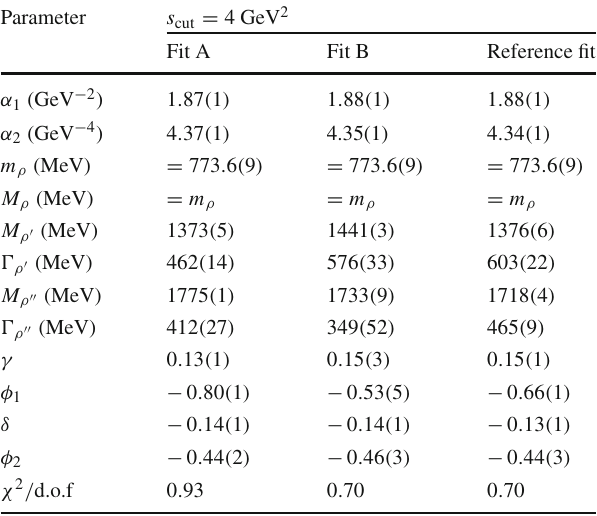
Table 3 Results for the fits obtained with a three-times-subtracted dis- persion relation including three vector resonances in F π to Eq.(26) with s cut = 4 GeV 2 in the dispersive integral with (second column) and without (last column) the K ¯ K channel in the ρ (cid:4) and ρ (cid:4)(cid:4) energy-dependent resonance widths, and with the additional inclusion of the ρ (cid:4) → ωπ contribution into the ρ (cid:4) width (third column). See main text for details